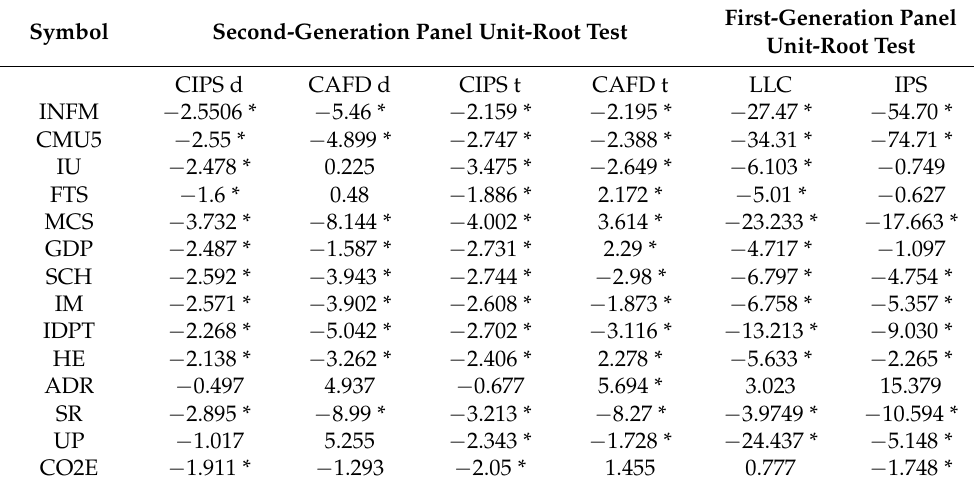
Table A2. Panel unit-root tests.